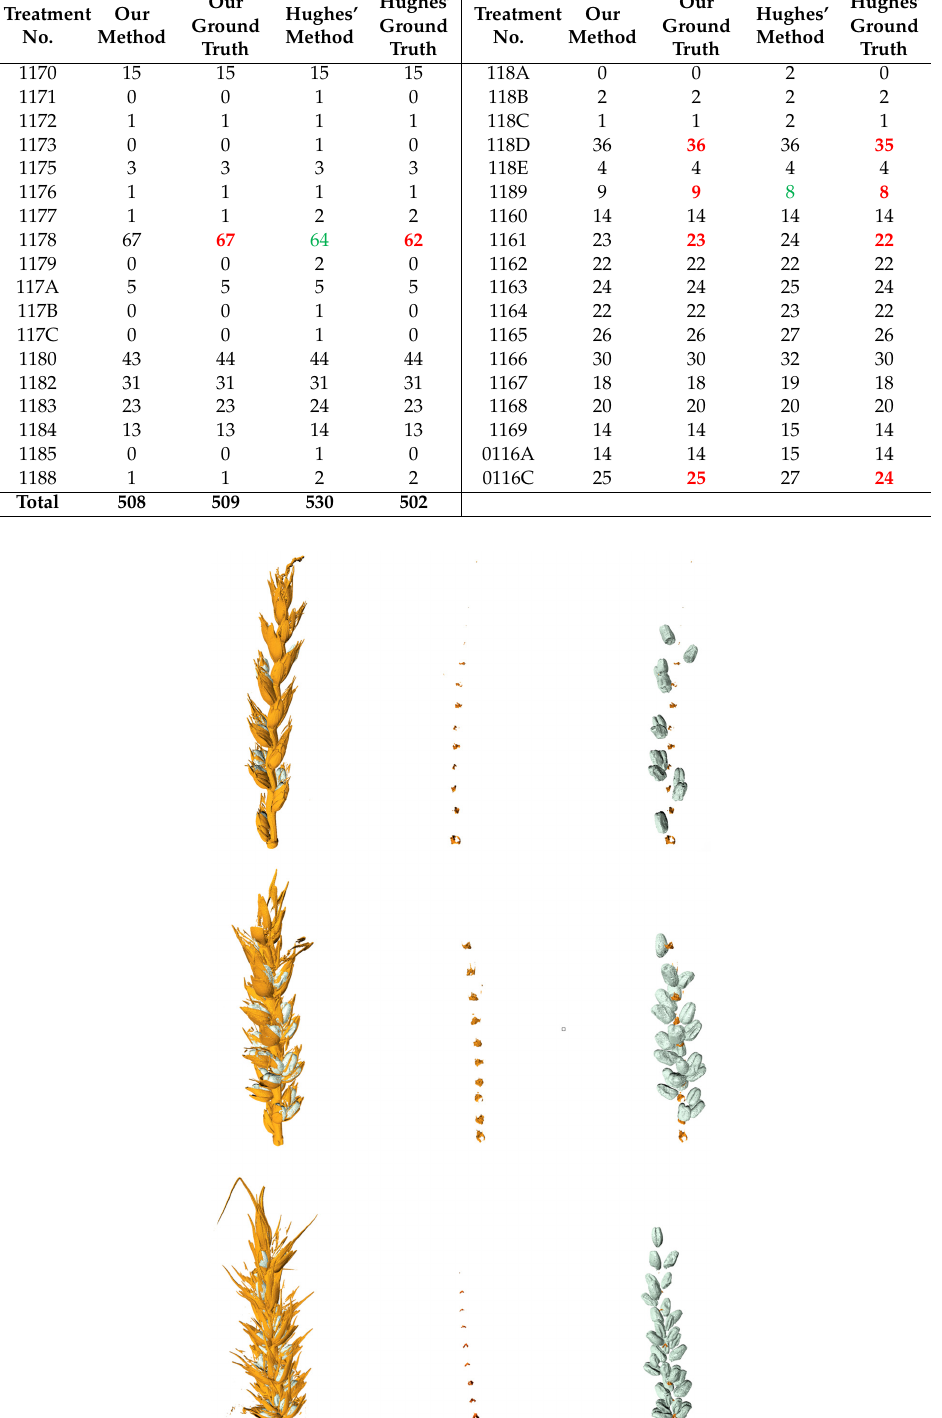
Table 2. The number of grains counted by the proposed method. The numbers in red show the di ff erence between the ground truth data between ours and Hughes’, the numbers in green mean the detected grain is di ff erent from our ground truth data.